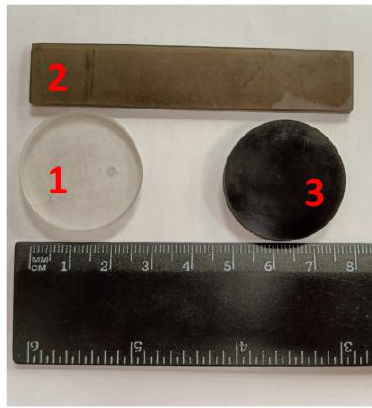
Figure 2. Samples of products obtained by DLP 3D printing: 1 — initial resin, 2 — 0.25 wt. % FLG, and 3 — 2 wt. % FLG.